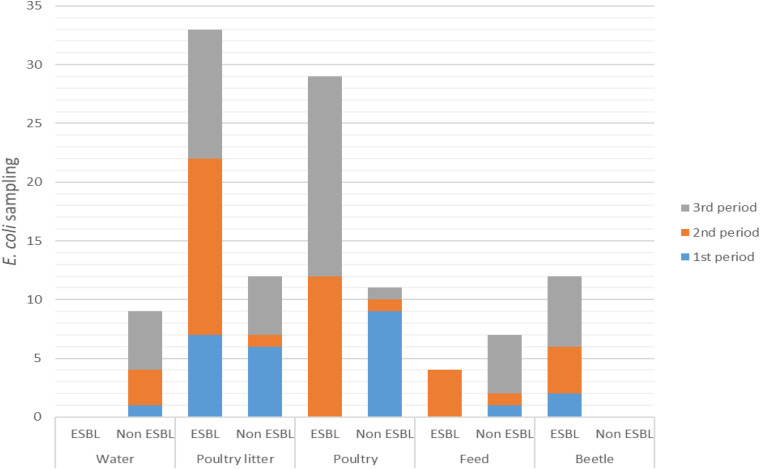
Distribution of ESBL-producing and non-ESBL-producing E. coli during the sampling periods.